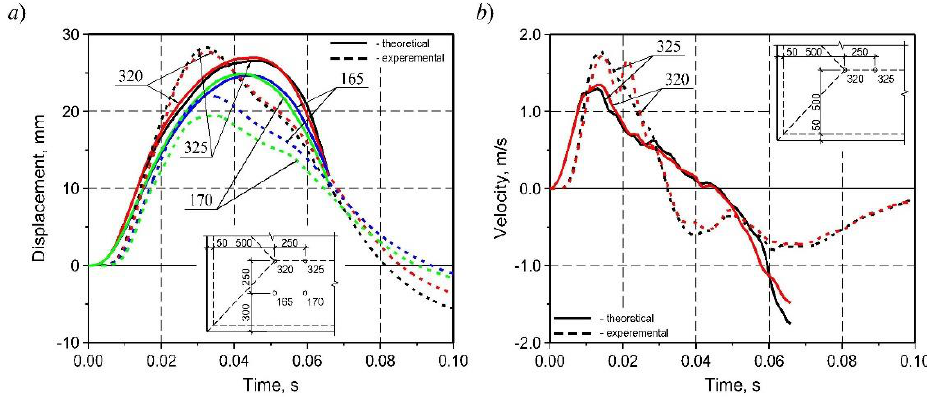
Fig. 4. Comparison of theoretical and experimental displacements ( а ) and velocities ( b ) of reinforced concrete slabs on elasto-plastic yielding supports.